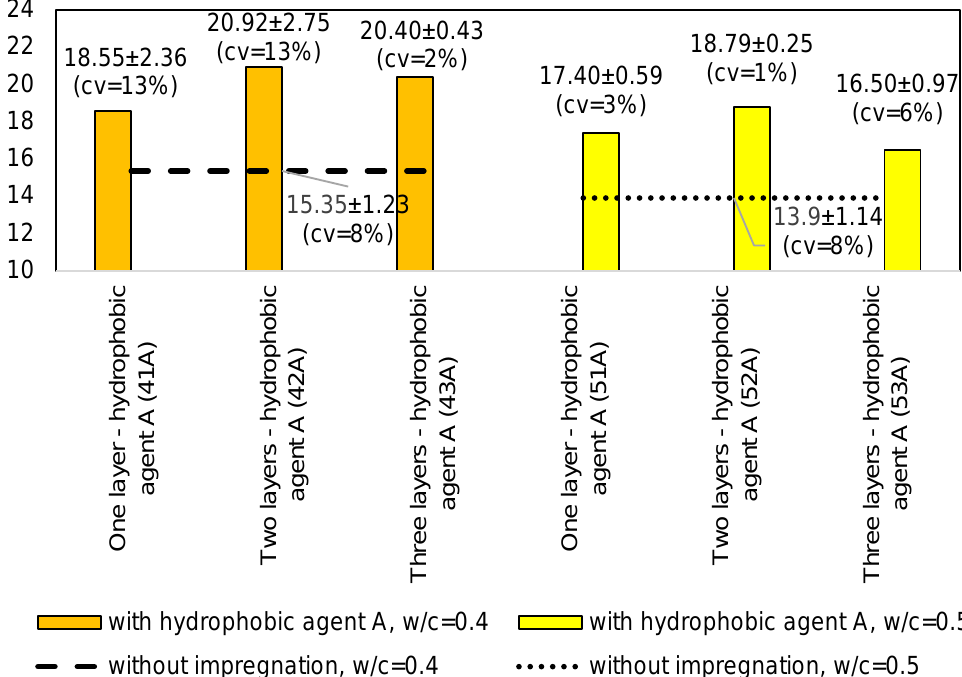
Figure 5. Rebound number comparison for samples with different w/c and impregnation using hydrophobic agent A.